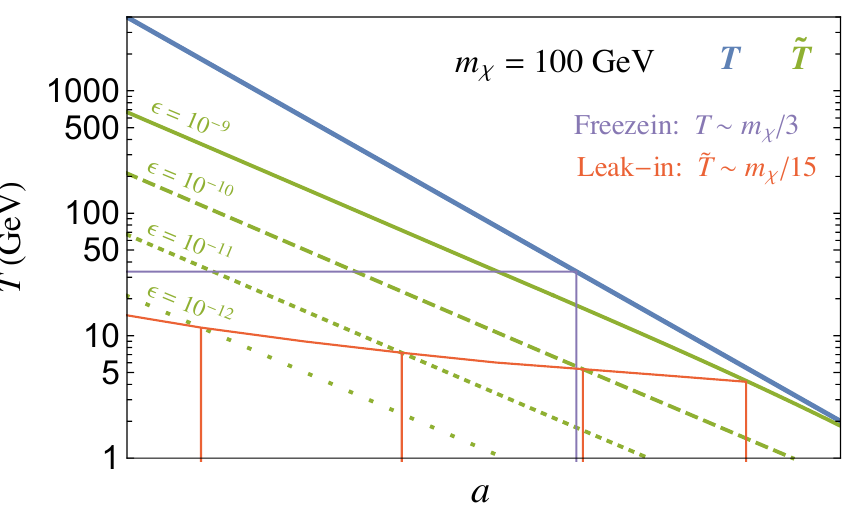
Figure 2. Evolution of the SM temperature T (blue) and the HS temperature ~ T (green) for four choices of the portal coupling (cid:15) . Freezein from the SM is dominated by SM temperatures T (cid:24) m (cid:31) = 3 (shown in purple), while leak-in DM is dominated by HS temperatures in the range ~ T (cid:24) m (cid:31) = 10{ m (cid:31) = 20, as indicated by the red curve. When freezein occurs prior to when LIDM would freezeout (as happens with the solid green line, (cid:15) = 10 (cid:0) 9 ), the injected DM particles can thermalize with the HS plasma, leaving little net contribution to the DM relic abundance. When freezein occurs after LIDM freezeout, it may have a signi(cid:12)cant impact on the (cid:12)nal relic abundance (as happens with the short dashed line, (cid:15) = 10 (cid:0) 11